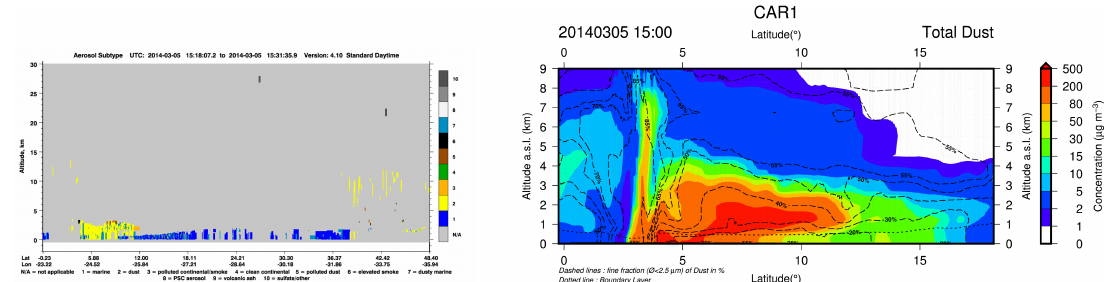
Figure 19. Cross section of CHIMERE dust concentrations ( right ) on 5 March 2014 15:00 UTC zoomed over the highest values area versus the corresponding CALIPSO qualitative data ( left ) showing in yellow the dust load and in orange the polluted dust, for the CALIPSO trajectory CAR1 as reported in Figure 2. The dotted line represents the height of the boundary layer, the dashed lines represent the fraction of fine dust in percent.